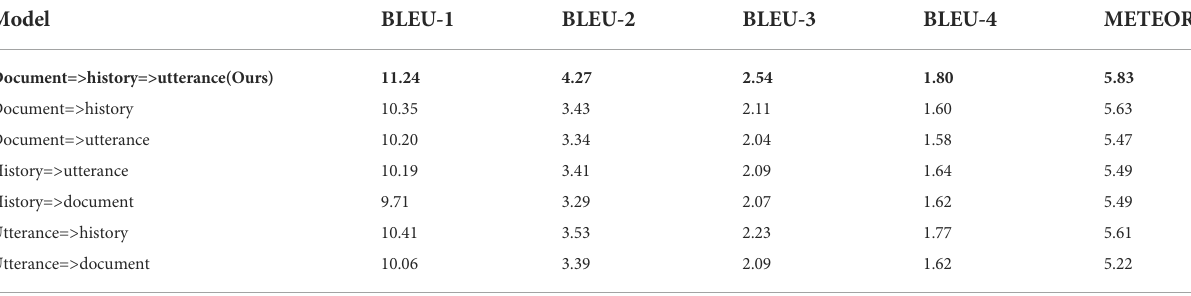
TABLE 8 Ablation study for the hierarchical decoding module on BLEU − n scores and METEOR. The symbol “ = > ” represents the decoding order from the bottom up. Model